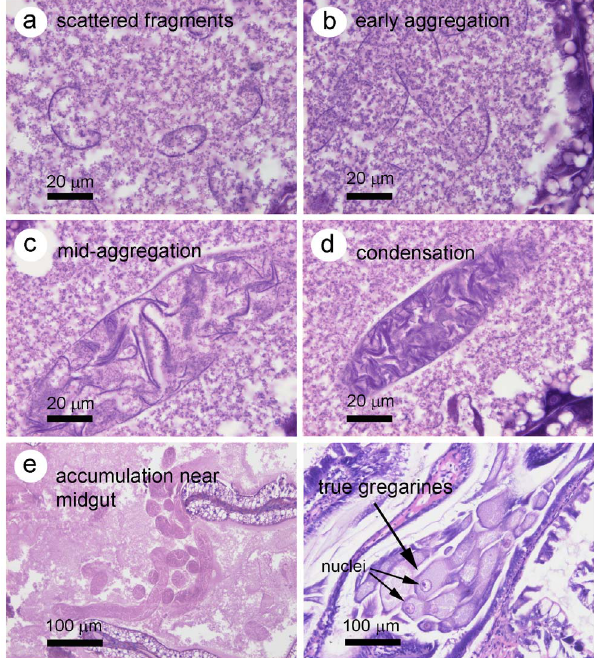
Figure 4. ATM aggregation steps in H&E stained HP tissue sections in comparison to true gregarines. (a) Small, scattered membrane-lie structures in the HP tubule lumen. (b) More extended membranes beginning to aggregate in the tubule lumen. (c) Tighter aggregation of membranes bound by a continuous outer membrane and taking the shape of ATM. (d) Highly condensed ATM in a tubule lumen. (e) Accumulation of many individual ATM at the center of the HP near the midgut junction. (f) True gregarines clustered near the midgut junction and showing prominent nuclei.